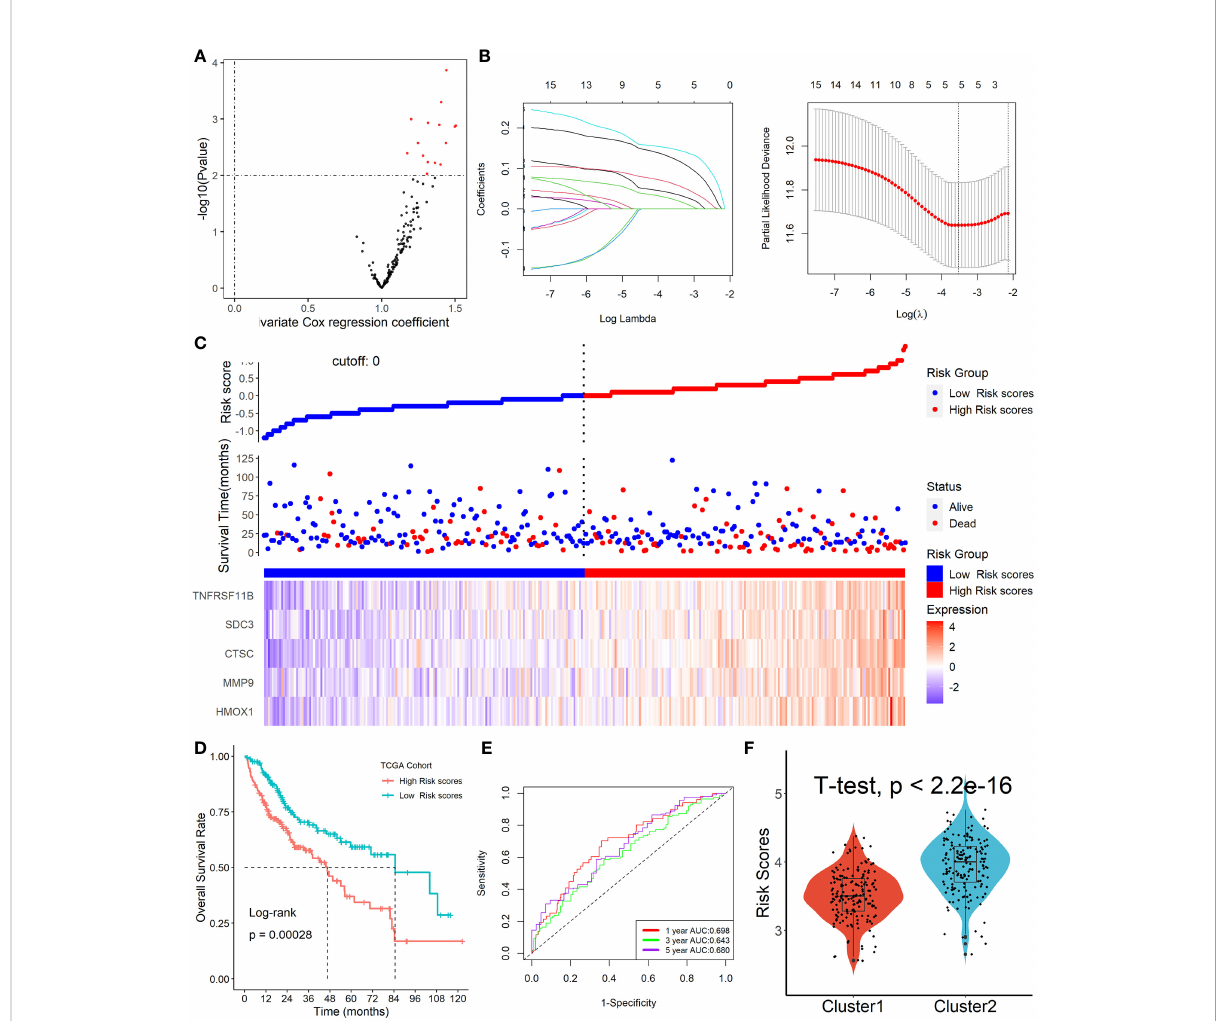
FIGURE 5 Formation of Tregs-related prognostic signature in HCC. (A) 15 prognosis-associated genes were identi fi ed by univariate Cox regression with a p-value less than 0.01. (B) Tregs-related genes were screened by the LASSO-Cox regression model. (C) Patients were divided into high- or low- risk scores subgroups with an optimal threshold after patients ’ risk scores were calculated with the above formula. (D) Patients with lower risk scores were remarkably relevant to better survival outcomes. (E) This Tregs-related signature had a good prognostic performance. (F) Patients in Cluster 2 had higher risk scores compared with patients in Cluster